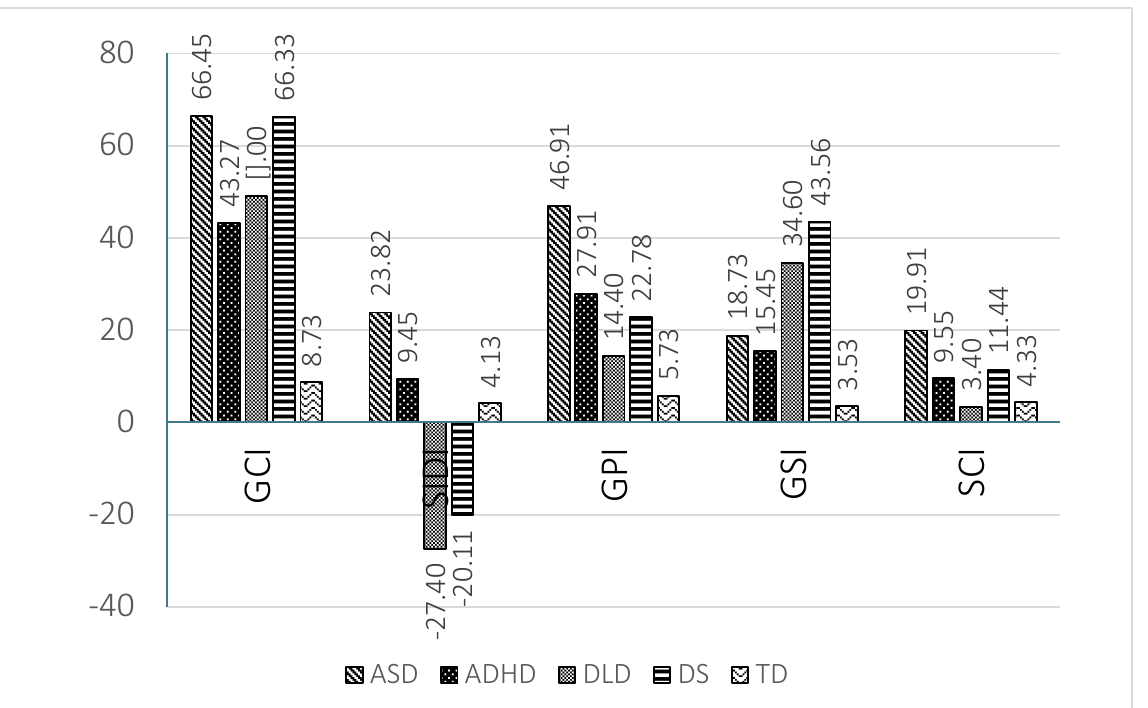
Figure 4. Means obtained by the 5 groups at school age in the indices of the Galician CCC-2.